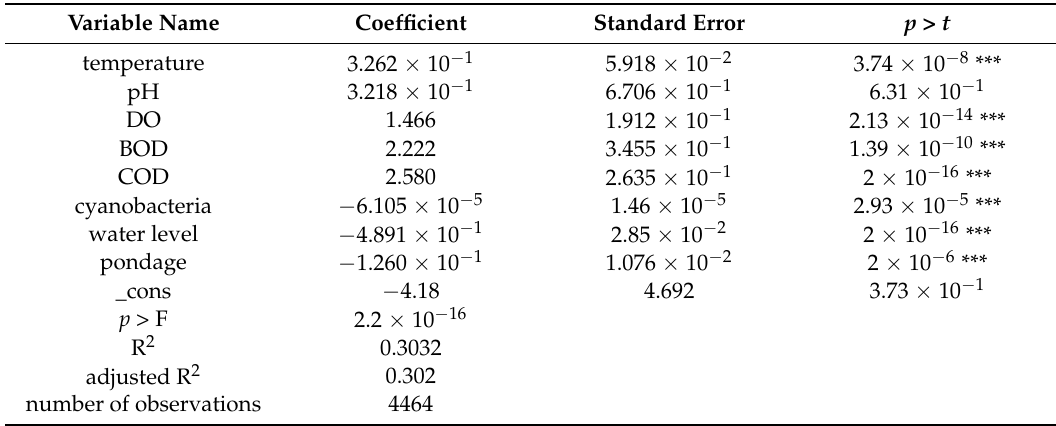
Table 2. Multiple linear regression analysis